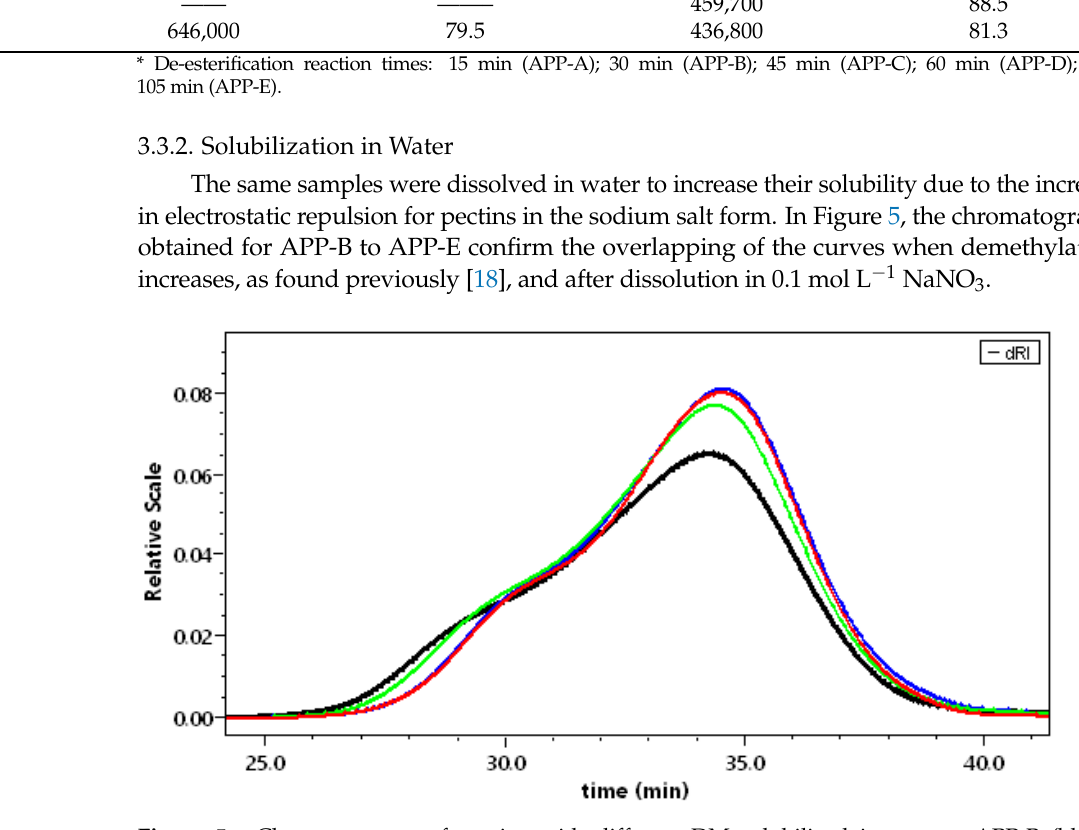
Figure 5. Chromatograms of pectins with different DM solubilized in water. APP-B (black); APP-C (green); APP-D (red); and APP-E (blue). APP-C (green); APP-D (red); and APP-E